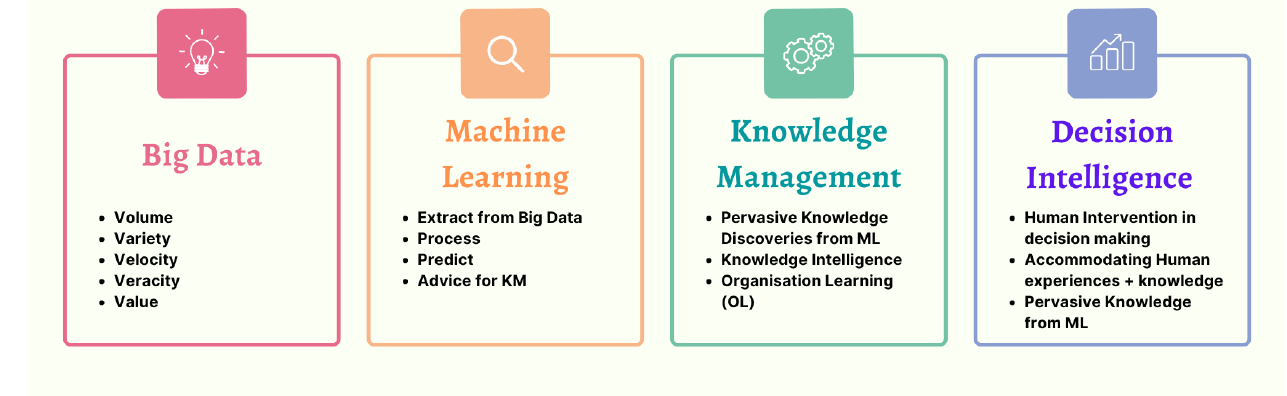
Figure 6. Value chains from big data to decision intelligence.